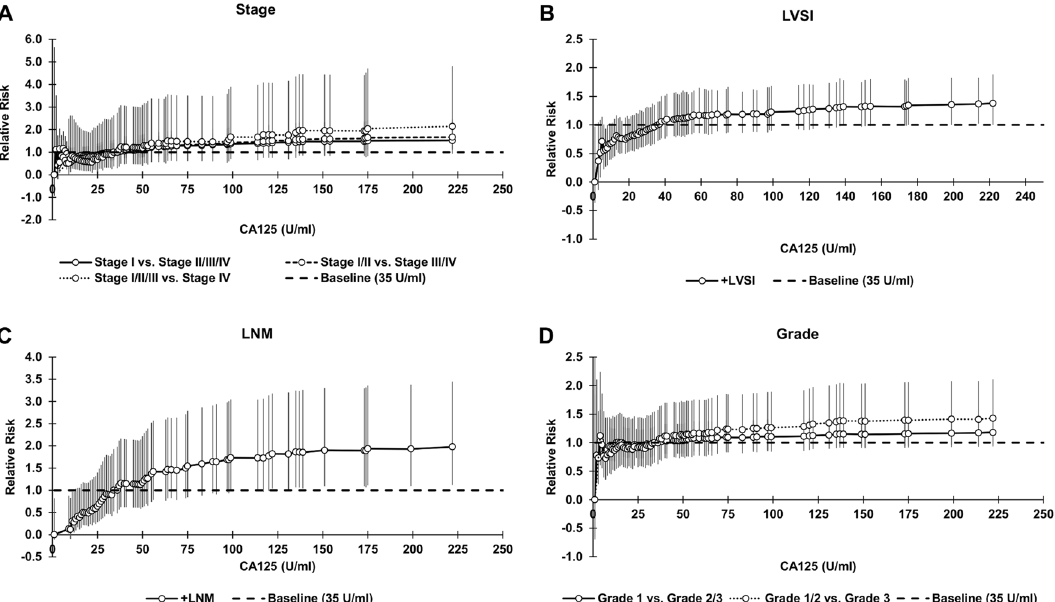
Figure 3. Relative risk (RR) for all CA125 thresholds from 1 to 222. RR for baseline CA125 of 35U/ml is equal to 1.0. P values for OR and RR were calculated with Fisher’s exact test using a two-sided 95% CI, where the CI was calculated using a normal approximation. Bars represent 95%